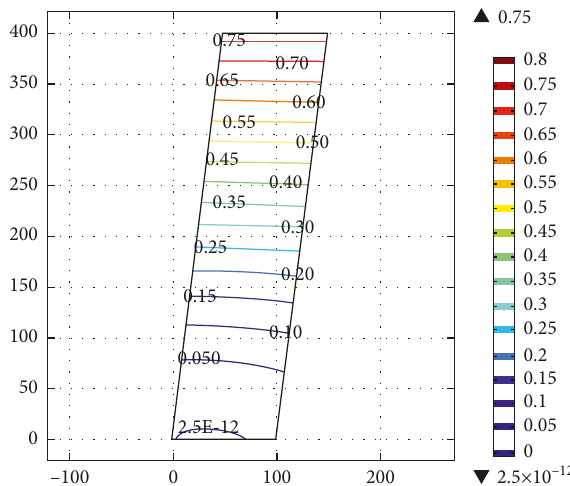
Figure 11: Horizontal displacement of the rock column at a mining depth of 400m.